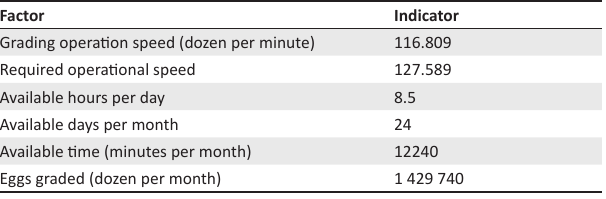
TABLE 12: Grading operation speed.